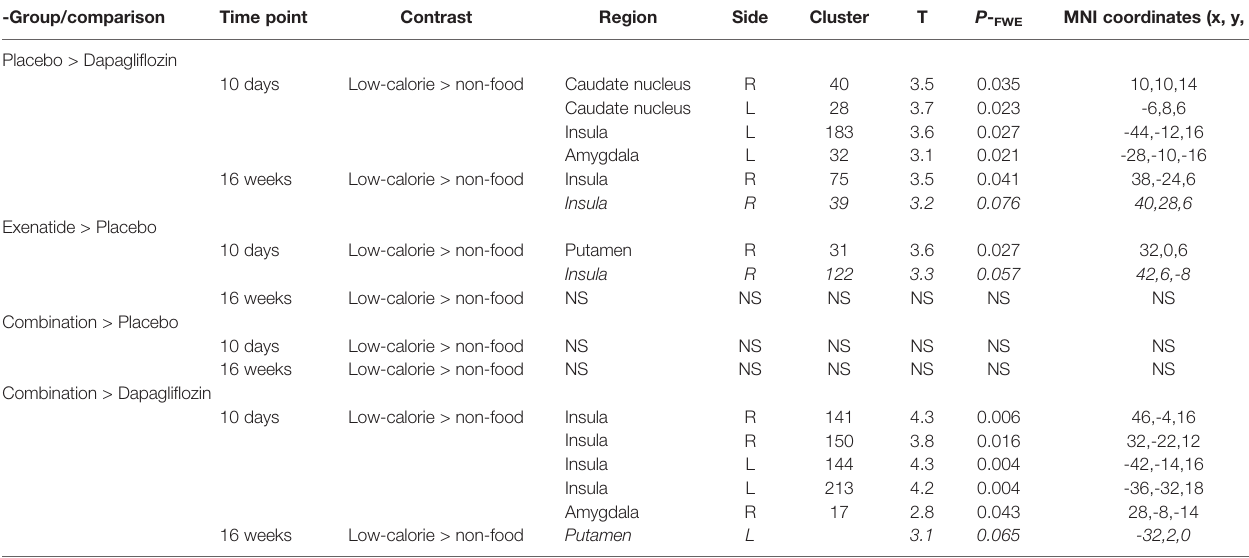
TABLE 2 | Effects of dapagli fl ozin, exenatide and the combination of dapagli fl ozin and exenatide on brain responses to low-calorie food pictures.